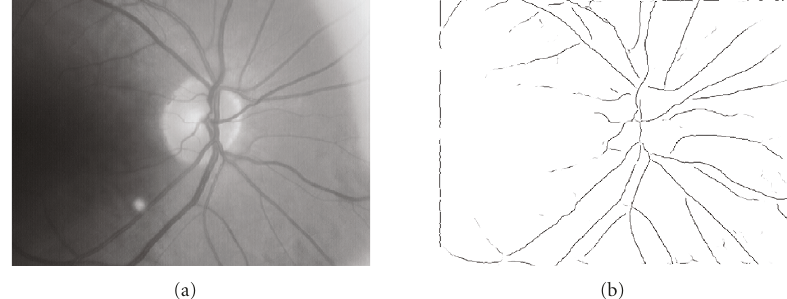
Figure 2: Example of digital retinal images showing the vessel tree. (a) Input retinal image. (b) Creases image from the input representing the main vessels in the retina.